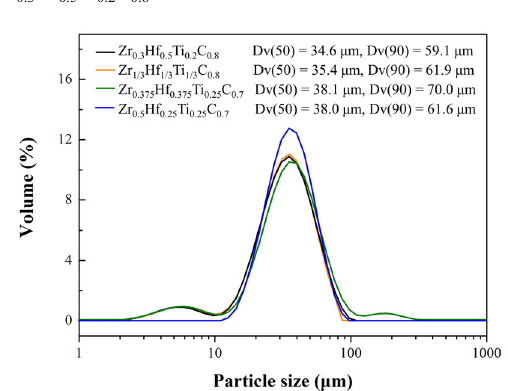
Fig. 3 Particle size distribution of (Zr,Hf,Ti)C x carbides after